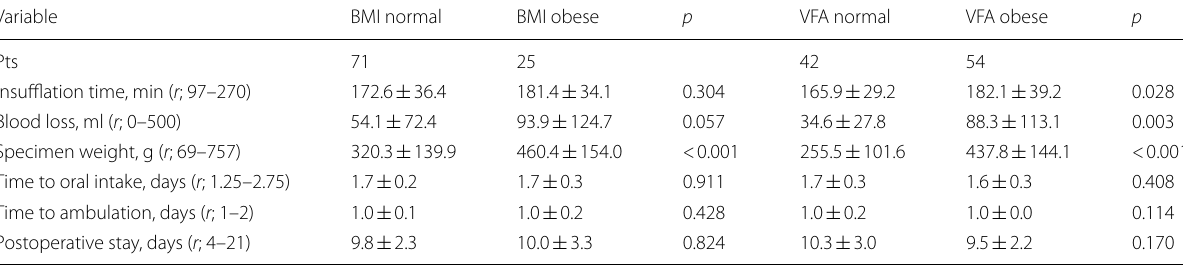
Data are presented as mean BMI body mass index, VFA visceral fat area